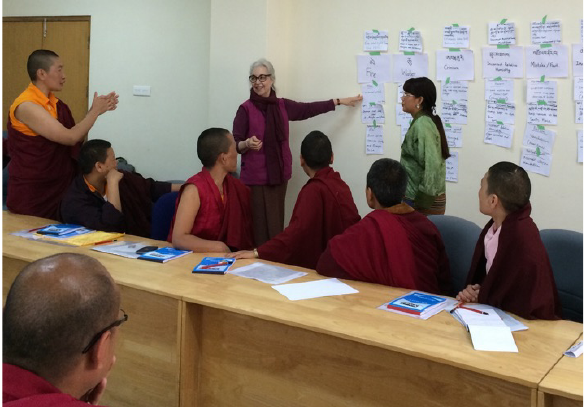
Figure 4. Risk Assessment group